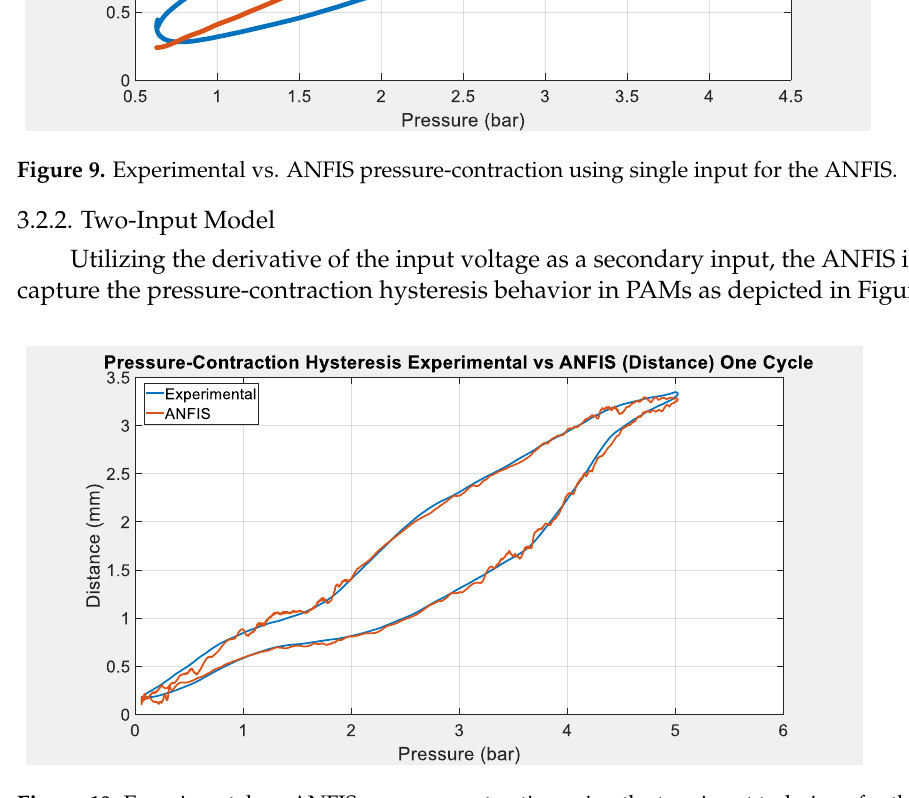
Table 1. ANFIS-normalized RMSE matrix at a voltage input of 0–5 volts and varying